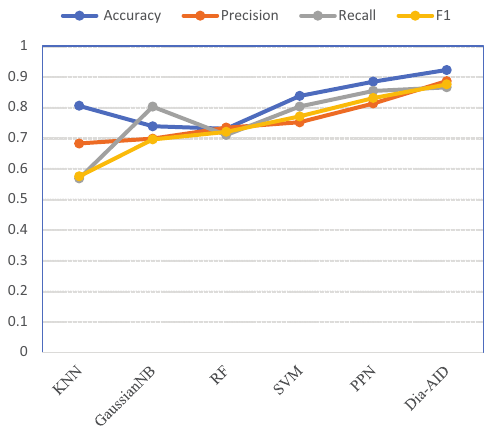
Figure 15. The evaluation for different classification methods in